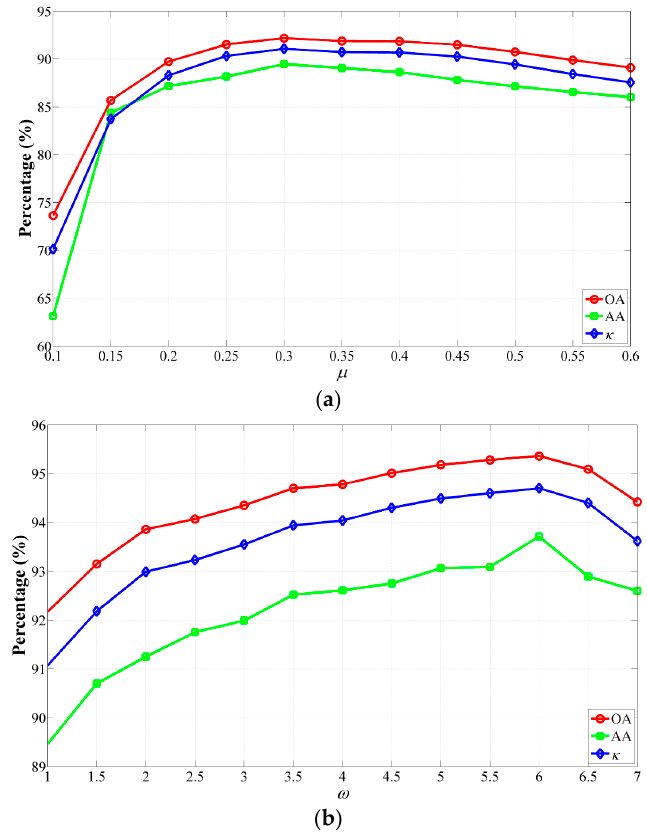
Figure 8. Analysis of the impact of μ and ω on classification accuracies using the CS-GC method for the Indian Pines data set. ( a ) Evolution of classification accuracies against different values of μ ; ( b ) evaluation of classification accuracies against different values of ω .